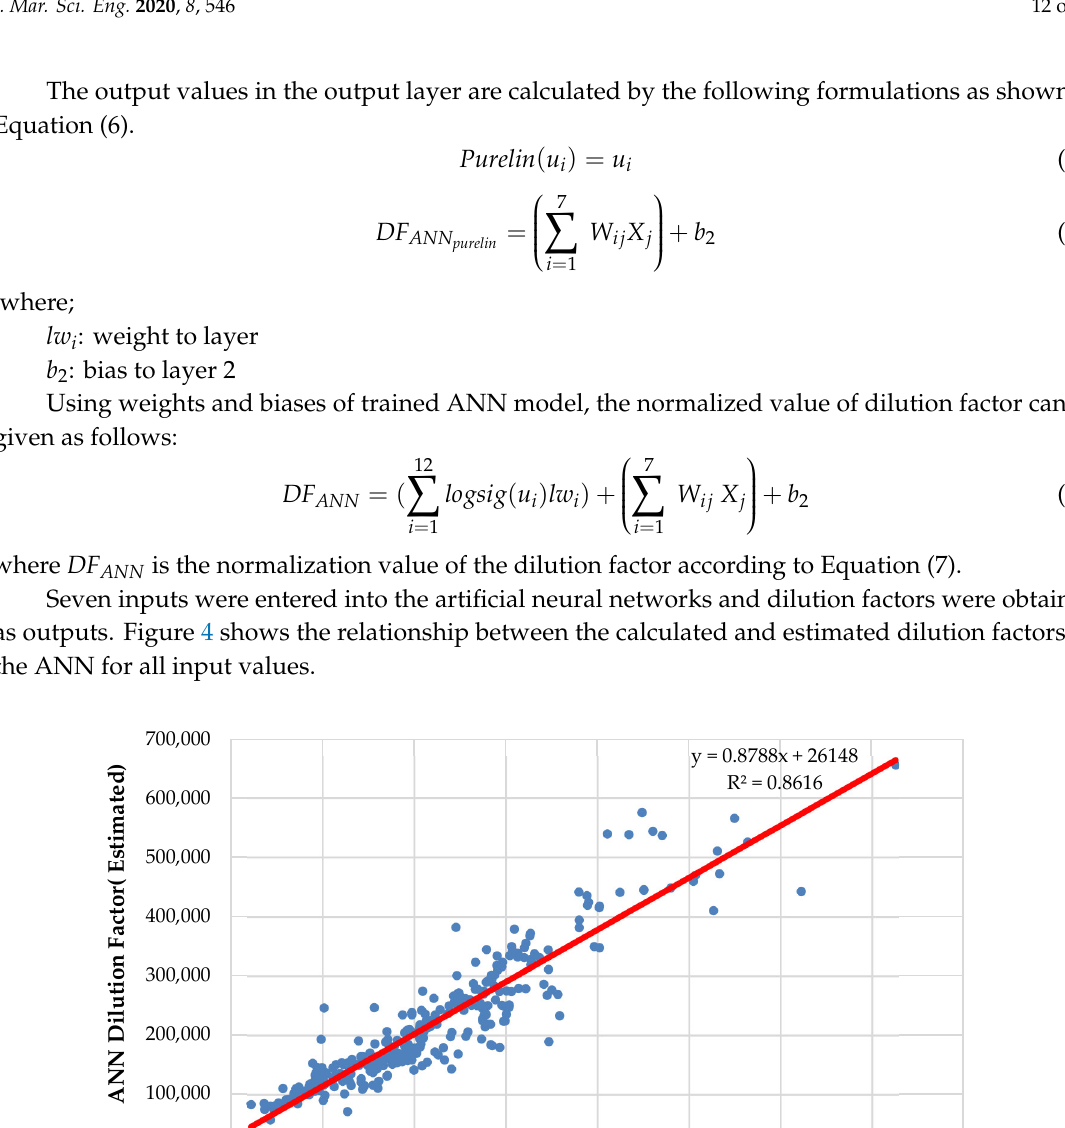
Table 5. Rates of importance of ANN for all inputs.